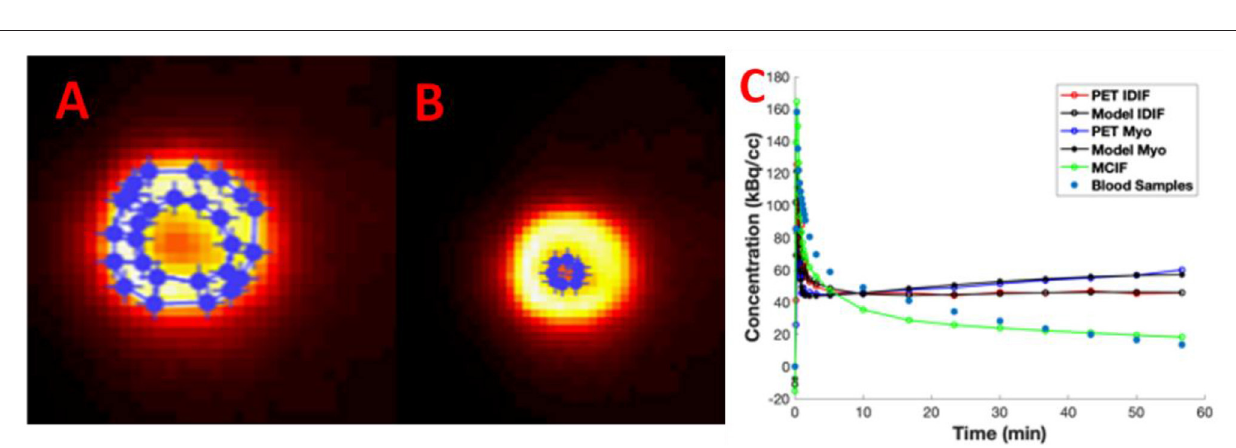
In Figure 5A , the W. Schiffer T2 rat brain atlas fused with a coronal slice of a late time point dynamic PET image is shown for an example WKY rat. Bland–Altman analysis was used to compare the two methods, including tests for similarity and model bias. Bland–Altman analysis between computed and measured K i for the 35 VOIs contributing to the four super regions for five WKY rats (175 data points) revealed a mean